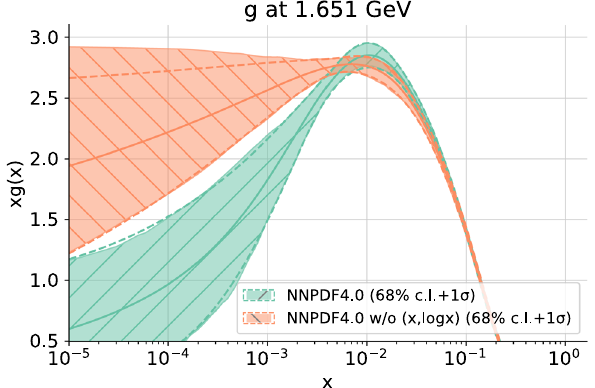
Fig. 2 Comparison between the gluon PDF generated with the stan- dardNNPDF4.0methodology(green)andourmodificationinwhichwe have removed the splitting layer of x to ( x , log x ) (orange). While we observe good compatibility between both PDFs in the large- x region, as we enter in the small- x region our modified PDF saturates. This is evi- dent also in the χ 2 of the modified fit which was blocked at χ 2 = 1 . 20 while NNPDF4.0 is able to get it down to χ 2 = 1 . 16